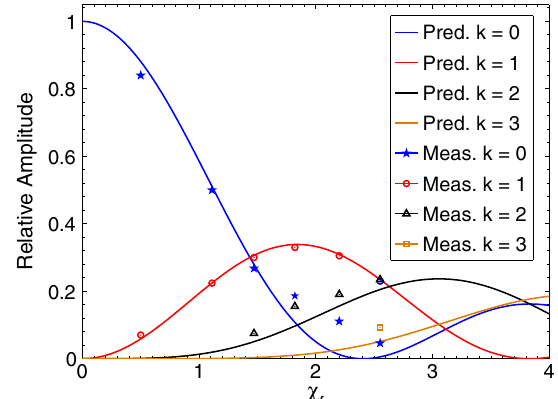
FIG. 22. Chromaticity measurement using the method shown in Fig. 21 over the possible range of operation at SIS-18. The black dashed line marks the measured natural vertical chroma- ticity of SIS-18. The error bars for the chromaticity measurement are determined mainly by the electronic noise in the amplifier chain of the TOPOS system.